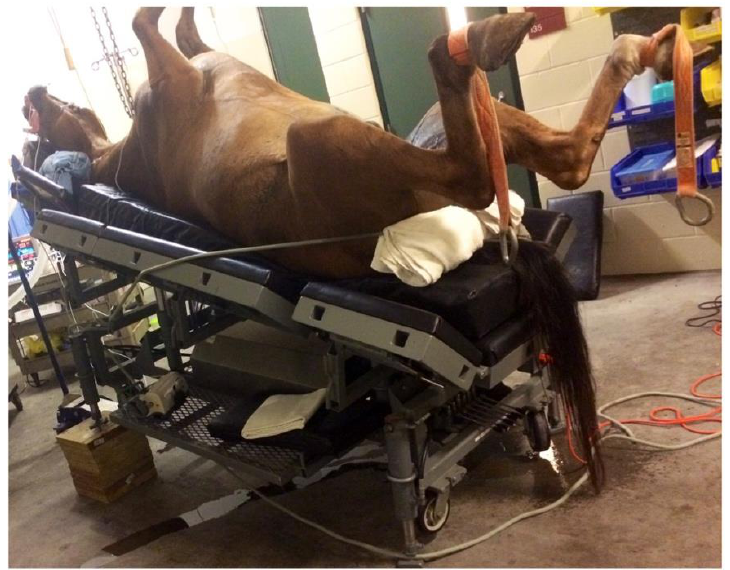
Figure 1. Isoflurane-anesthetized horse positioned in a 15° reverse Trendelenburg. To prevent the possibility of horses sliding off the table, a rope padded with towels was placed around the horse’s hindquarters, approximately at the level of the ischiatic tuberosity, with each end secured to the head of the table.